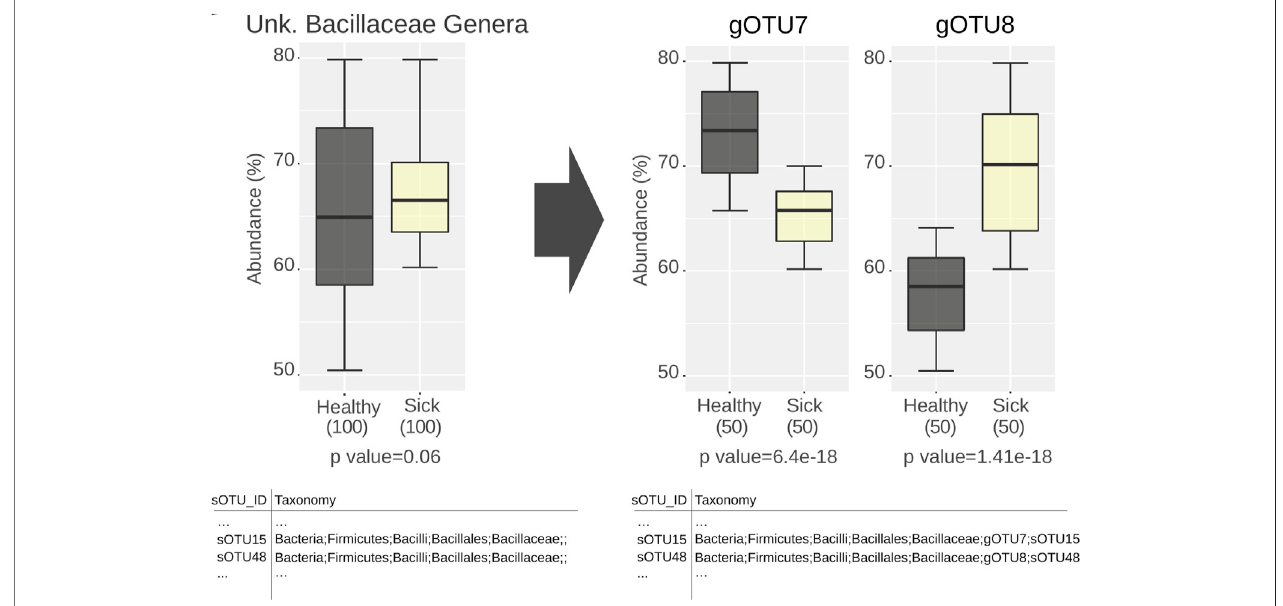
FIGURE 1 | Schematic representation of the shortcomings of missing detailed taxonomic assignments in microbiome analysis. OTUs missing taxonomic classi fi cation for a certain level (e.g., genus) are analyzed together under the unknown label. The resulting conclusions can be deceiving when the constituting natural divisions are present nonuniformly across